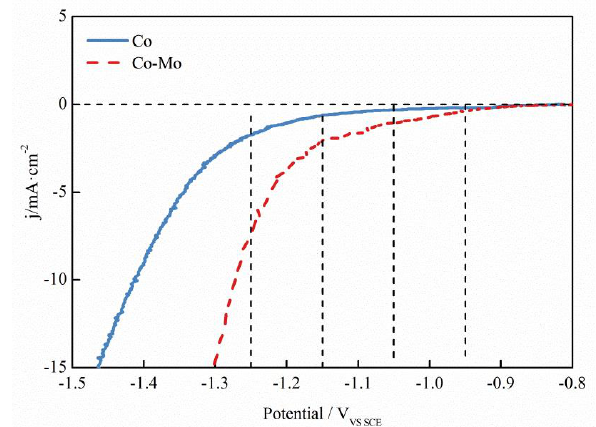
Figure 7. Linear sweep voltammograms of Co and Co-Mo electrolytes.